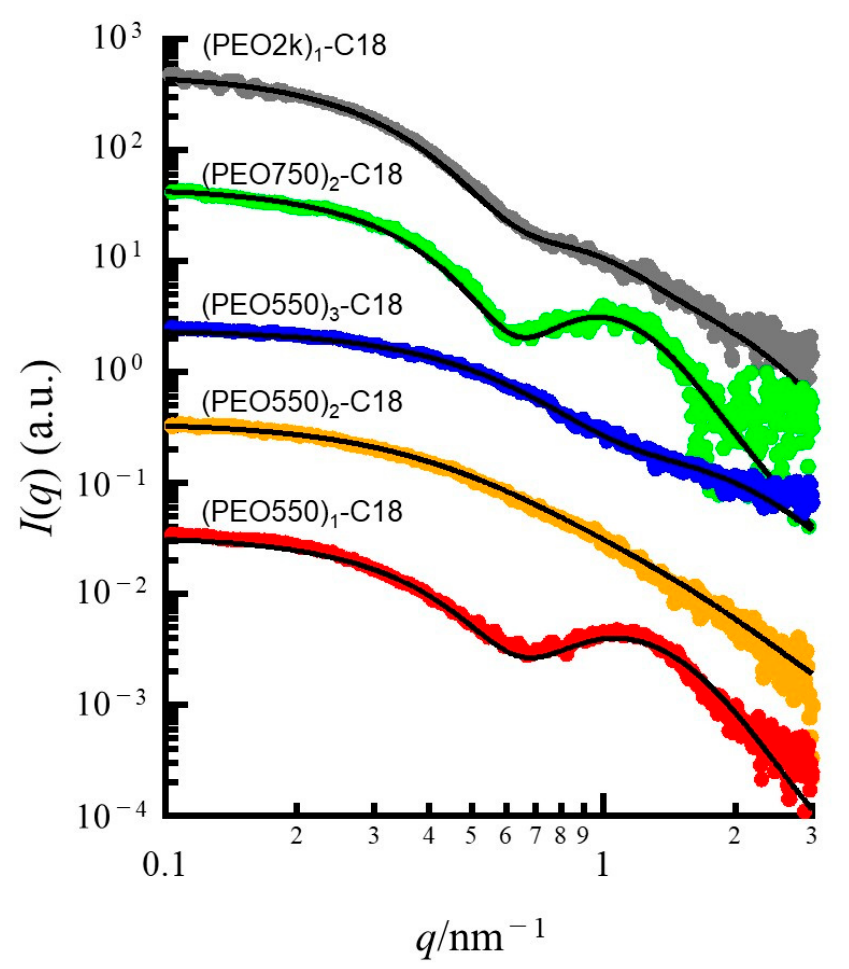
Figure 3. Small-angle X-ray scattering (SAXS) profiles of polymer micelles of (PEO2k) 1 -C18, (PEO550) 1 -C18, (PEO750) 2 -C18, (PEO550) 2 -C18, and (PEO550) 3 -C18. (PEO2k) 1 -C18, (PEO750) 2 - C18 and (PEO550) 3 -C18 are the almost same volume fraction of PEG in one (PEO x ) y